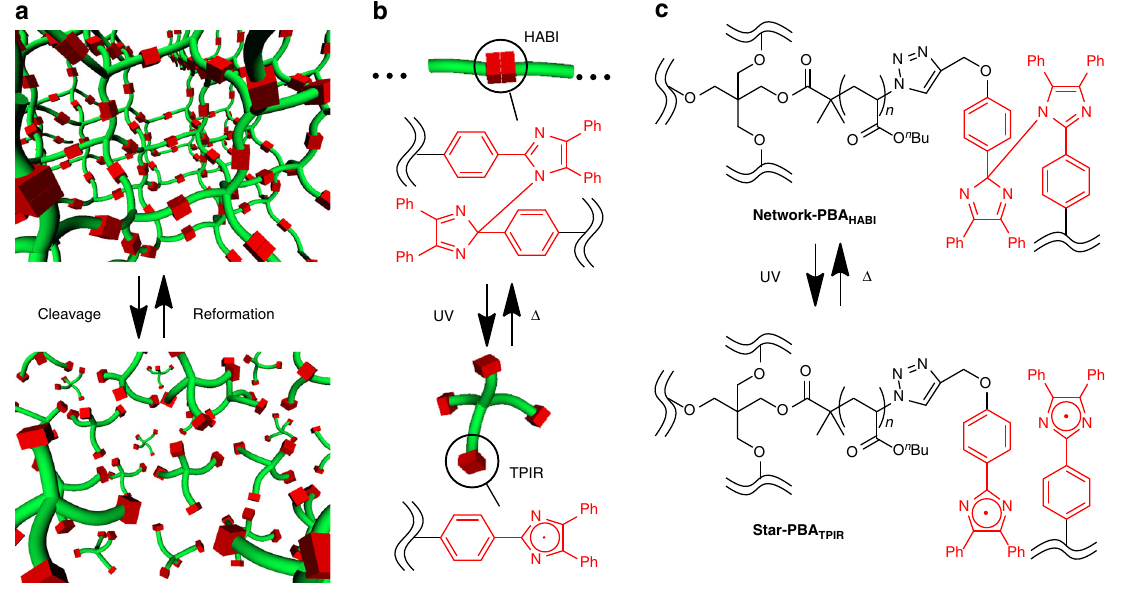
Fig. 1 Design of star – network repeatable MAT system with PBA. Schematic representation of a star – network repeatable MAT, b cleavage and reformation of the covalent bond in HABI, and c repeatable MAT between network-PBA HABI and star-PBA TPIR based on UV-triggered bond cleavage and